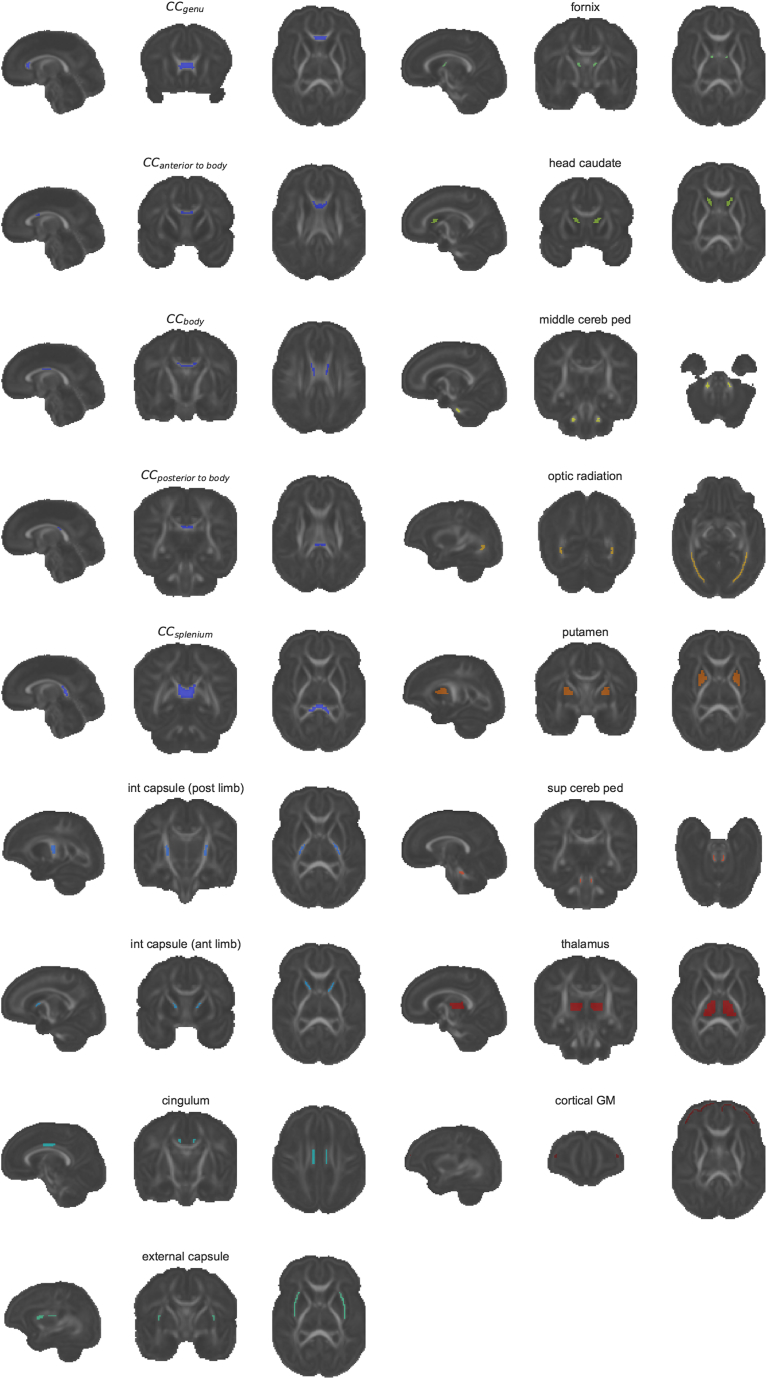
Slices showing all regions of interest, individually overlaid onto the age-average FA image. The focus of the projections coincides with the centre of mass of each region of interest.